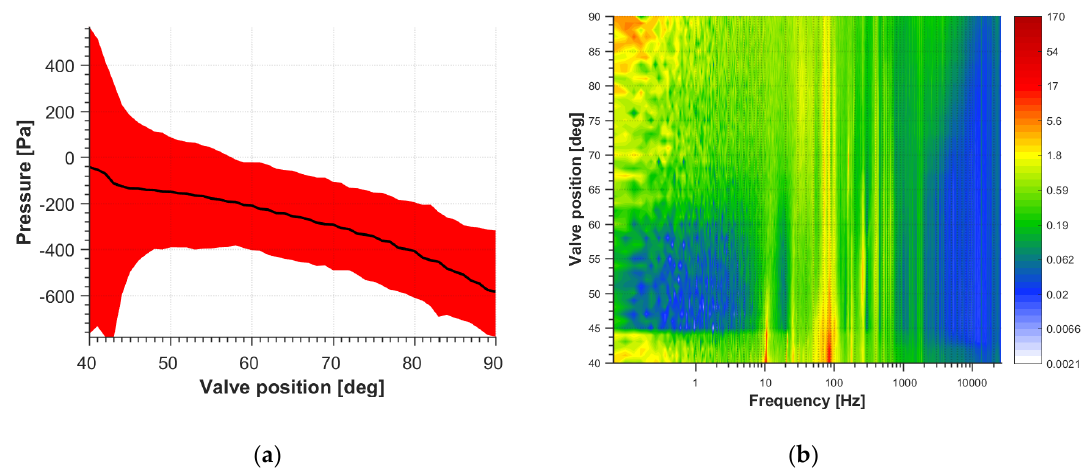
Figure 15. Pressure variation depending on the valve position measured at the inlet at impeller rotational speed 120 Hz. ( a ) The left plot represents the min-to-max plot (red) and the pressure average value (black). ( b ) The right plot represents the spectral map with the colormap in the logarithmic scale. The inlet pressure gradually increased with the valve closure (for decreasing valve